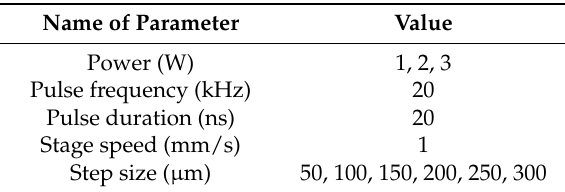
Table 1. Process parameters of the laser beam machining.